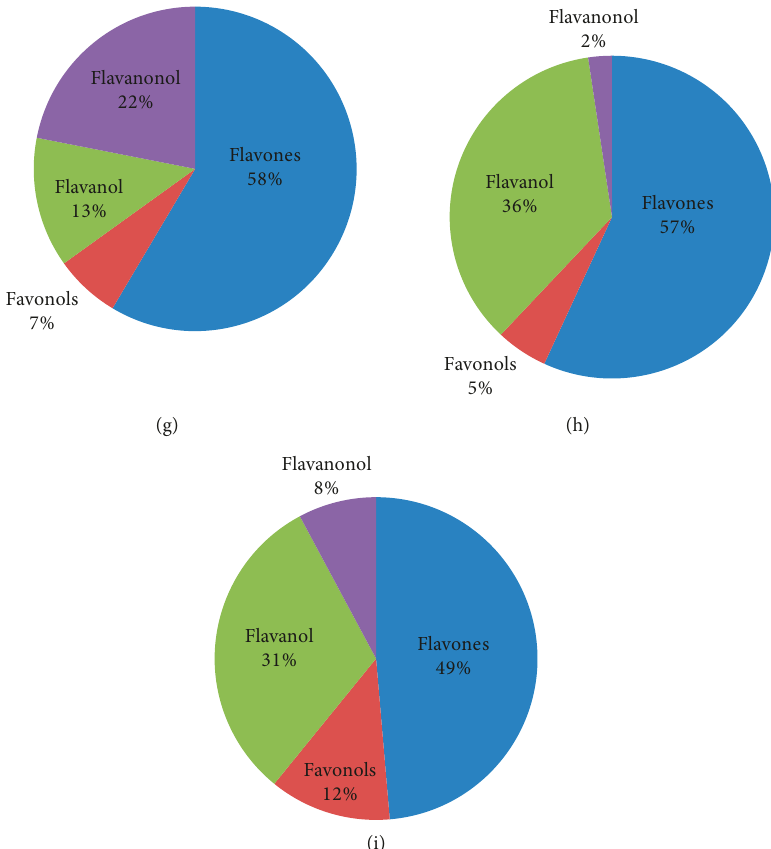
Figure 6: Flavonoid subclasses distribution. (a) El Hajeb. (b) Ghraiba. (c) Gabes. (d) Jelma. (e) Kondar. (f) Lamta. (g) Zaghouan. (h) Sidi Bou Ali. (i) Teboulba.